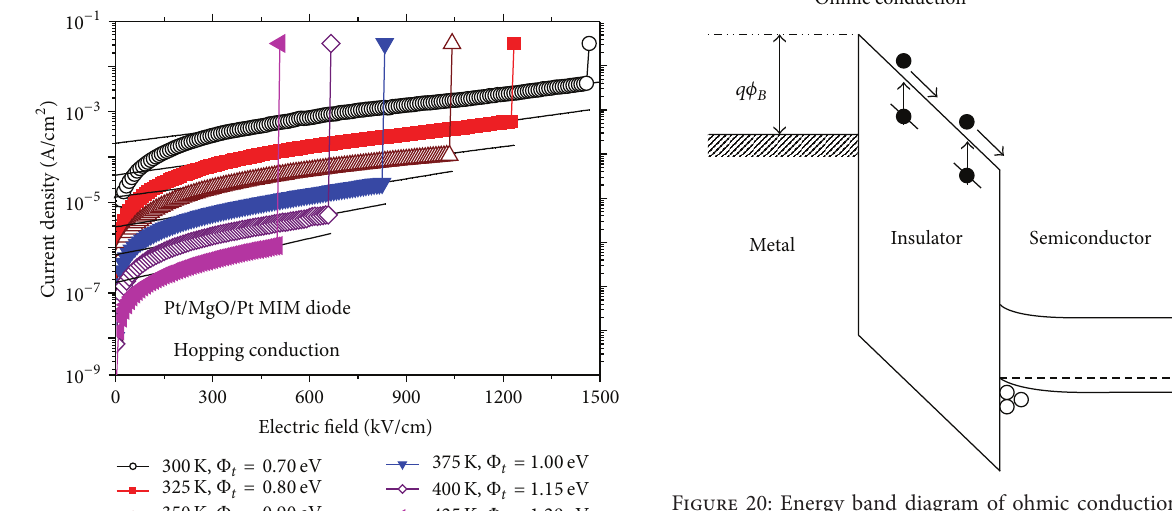
Figure 20: Energy band diagram of ohmic conduction in metal- insulator-semiconductor